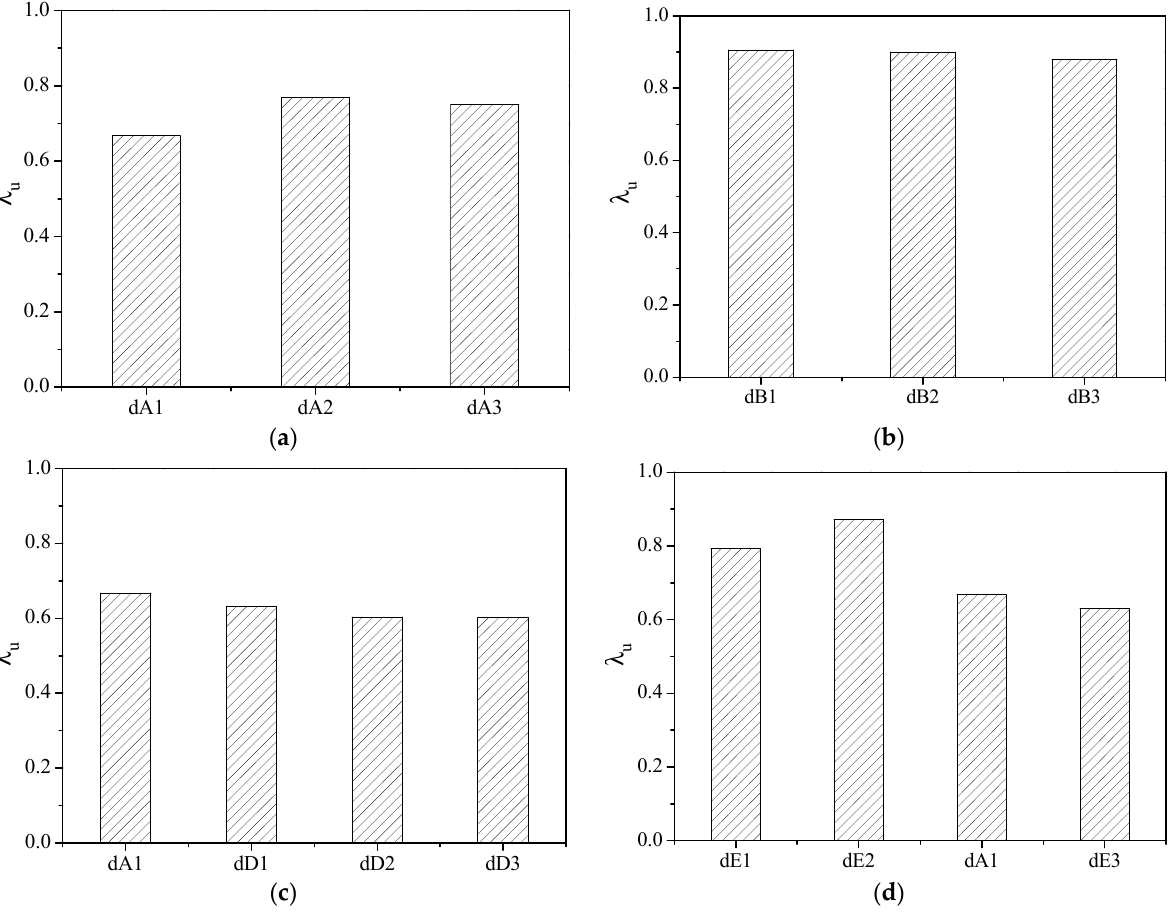
Figure 7. Influence of various parameters on the degradation coefficient of the ultimate bond strength. ( a ) compressive strength; ( b ) flexural toughness; ( c ) cover thickness; ( d ) anchorage length.